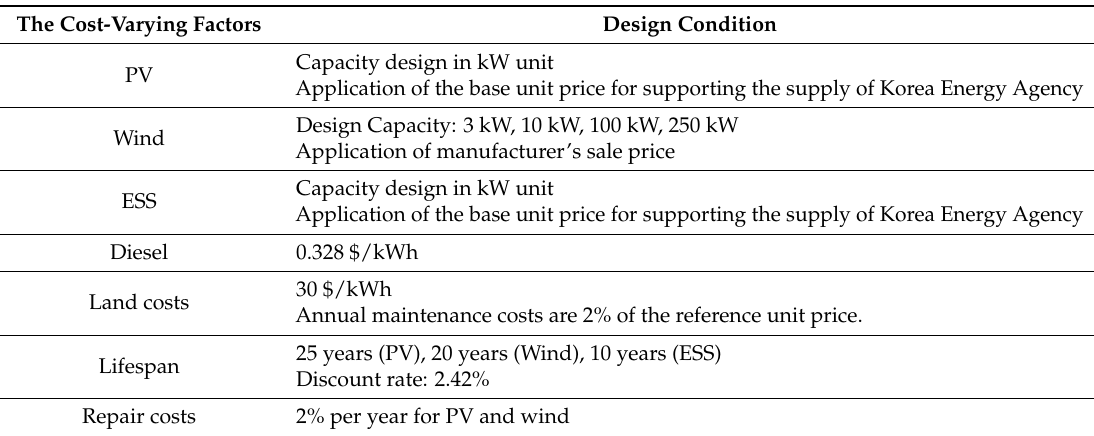
Table 5. List of the cost-varying